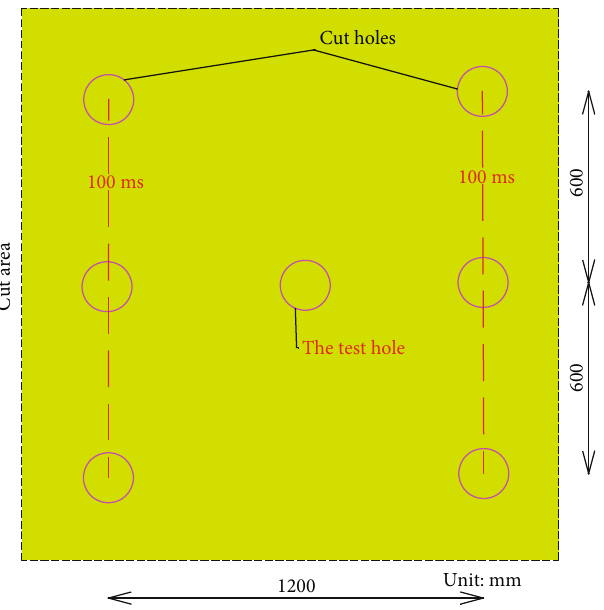
Figure 5: Arrangement of test holes in the cut